Question: Which visualization type does this figure use?
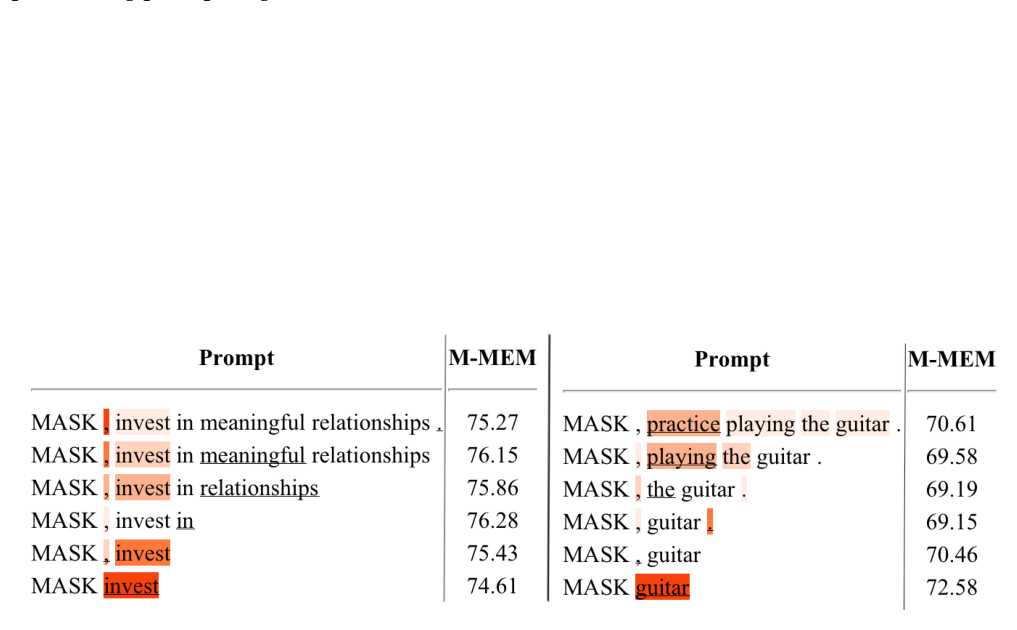
Answer: heatmap